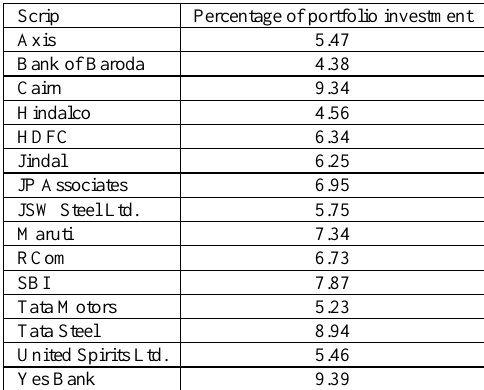
Table 6. Preferable efficient solution